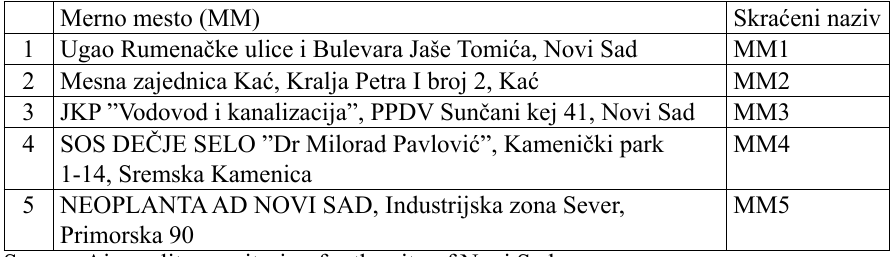
Table 1. local network of measuring points for measuring the level of pollutants in the air for the territory of the City of Novi Sad Merno mesto (MM) Skraćeni